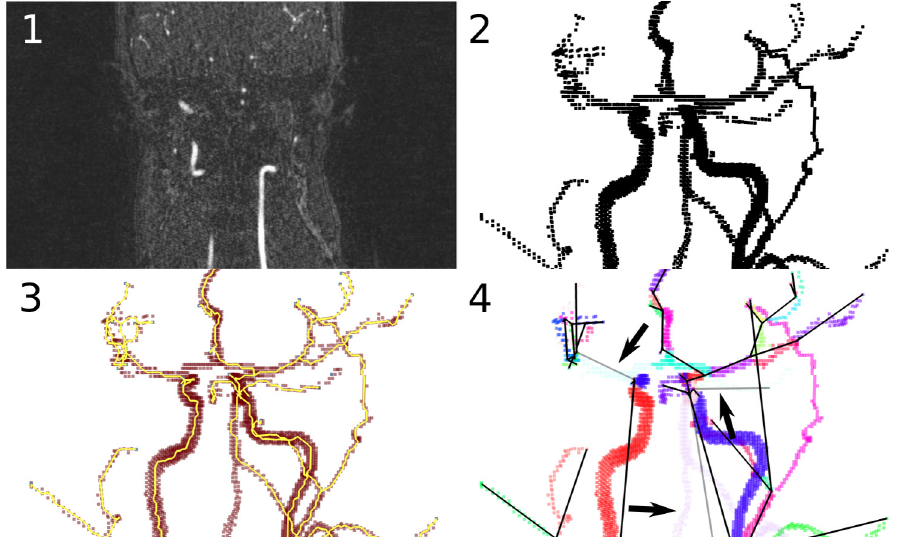
Fig 6. Images from each step of the automatic vessel segmentation process implemented by our software, angicart. 1. Midplane 2D slice from MRI input (original imagery). The input to the software is any tomographic imagery, regardless of imaging method. MRI, CT, and MicroCT are all possible data sources. 2. The network mask (3D rendering of included points). This is the largest group of connected pixels that exceed an intensity threshold. 3. The skeleton. Angicart skeletonizes the vessel network by removing any (red) points that do not disconnect the endpoints (pale blue). The points that remain after this process is completed are the centerline (yellow). Branch points are those with more than two neighboring voxels, and endpoints are those with only one neighboring voxel. 4. Vessel segment decomposition. Angicart partitions the skeleton into vessel segments. Each segment is colored randomly, and black lines are used as a simple map of the endpoints of each segment. Some segments (depicted translucent and indicated by black arrows) are ignored by the analysis, in this case due to reticulation present in normal human